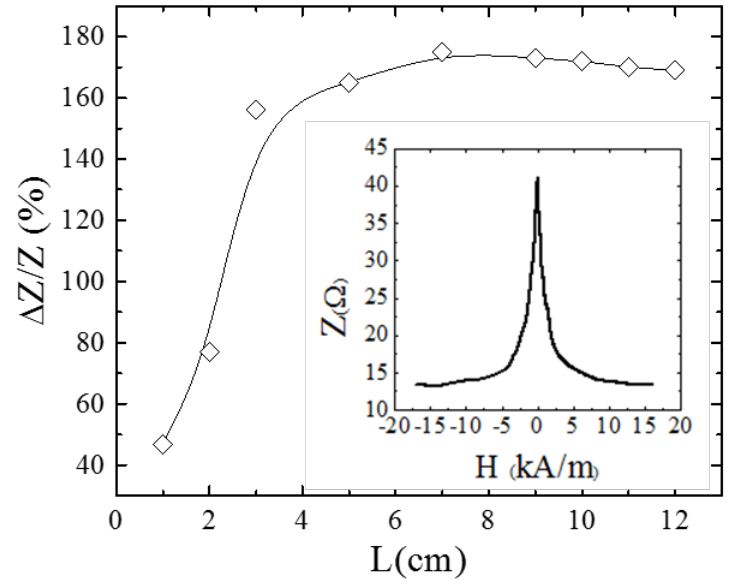
Figure 2. Giant magnetoimpedance (GMI) ratio ∆ Z (%) as a function of the wire’s length. Inset: Z versus the applied magnetic field, H , for L = 3 cm, ( f GMI = 300 kHz and I pp = 19 mA). Subsequently, the response of the sensor to a non-homogeneous DC magnetic field, H z , was characterized employing a ferrite rectangular magnet (1.0 x 1.7 x 0.5 cm), by evaluating the changes of Z as a function of the relative distance, x , between the magnet top surface and the wire .